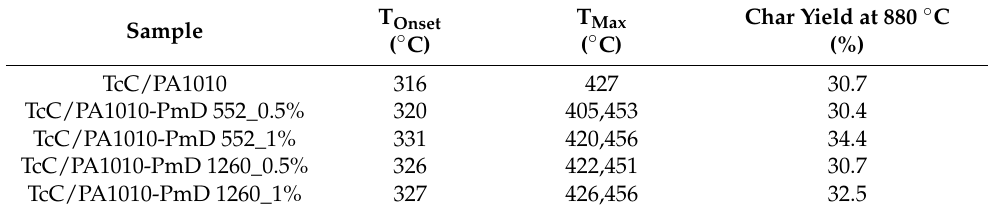
Figure 9. ( a ) TGA and ( b ) DTG thermograms of the thermally stabilised TcC/PA1010 filaments pre-impregnated with Primid 552 and Primid 1260. Table 5. TGA data of the thermally stabilised TcC/PA1010 without/with a cross-linker.